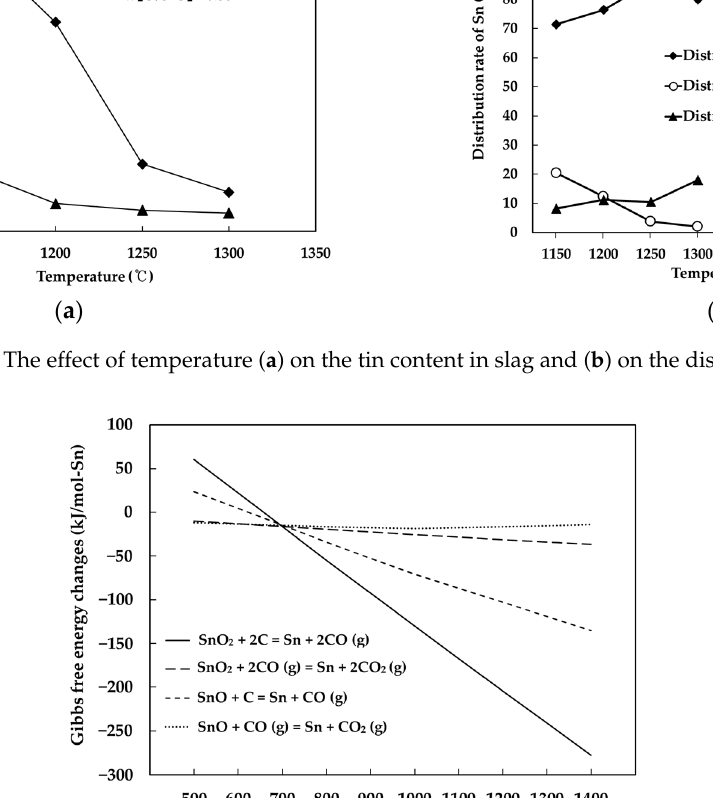
Figure 8. The condensed phase of volatilized tin by SEM/EDX analysis.